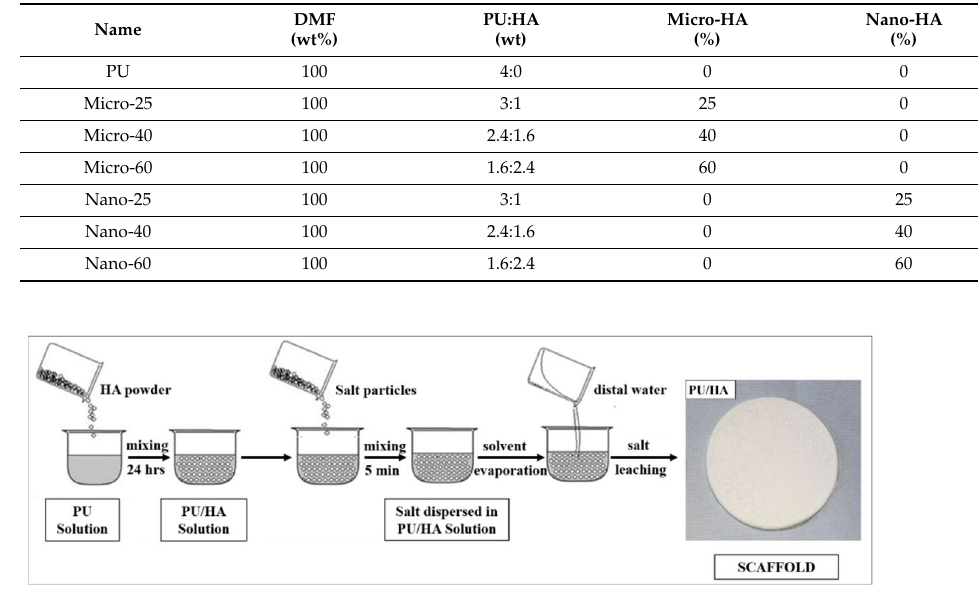
Figure 16. Diagram of Particles Leaching Method (PL)